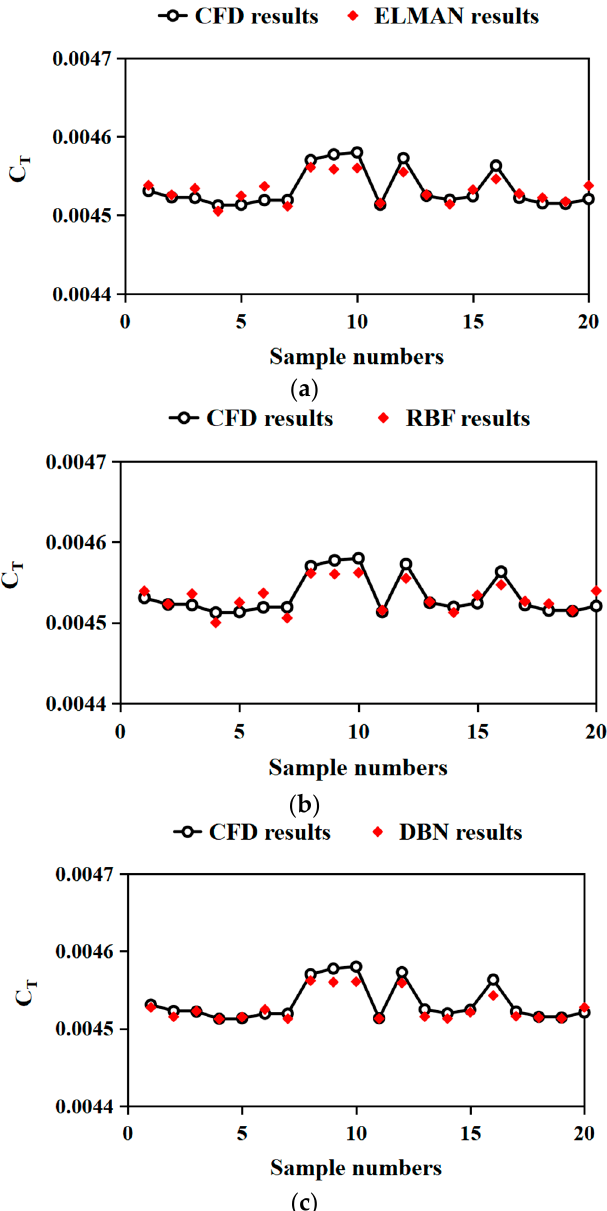
Figure 12. Comparison of the total resistance coefficient C T for different methods. ( a ) Comparison of the C T for CFD and ELMAN results. ( b ) Comparison of the C T for CFD and RBF results. ( c ) Comparison of the C T for CFD and DBN results.